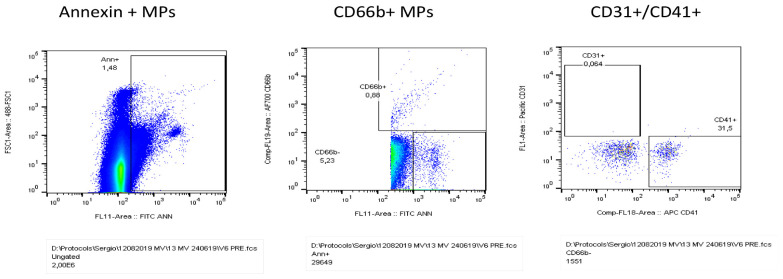
Flow cytometry gates definition for Microparticles analysis.